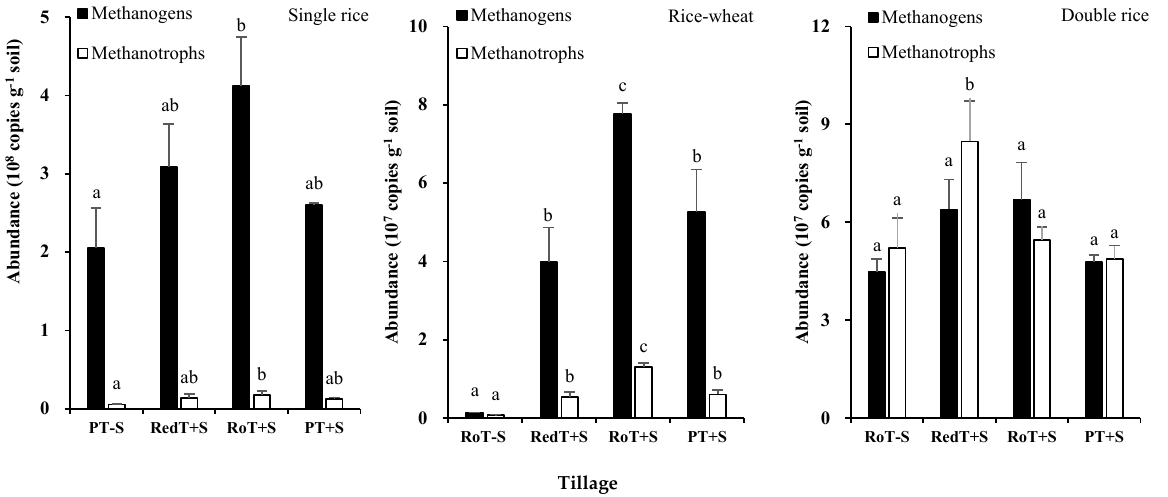
Figure 6. Impacts of straw incorporated tillage patterns on methanogens and methanotrophs PT − S indicates plough tillage + no straw, RoT − S indicates rotary tillage + no straw, RedT + S indicates reduced tillage + straw, RoT + S indicates rotary tillage + straw; PT + S indicates plough tillage + straw. Since the baseline of soil tillage was different, PT − S and RoT − S were respectively implemented as the control in different test sites. Mean ± SE; different small letters within the same column indicate significance at the 0.05 probability level in each treatment. Different capital letters within the same column indicate significance at the 0.05 probability level in each cropping system.